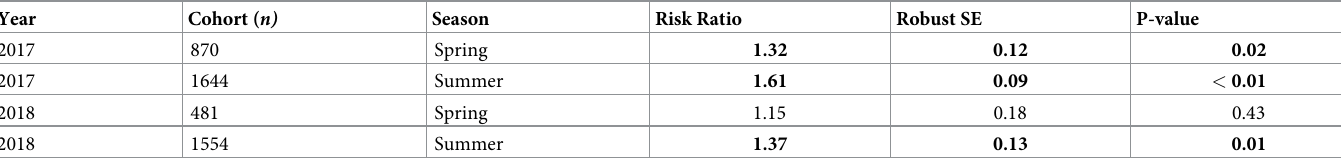
Risk ratios for roots born in the spring and summer seasons relative to the fall season in 2017 and 2018. Risk ratios > 1 show that risk of mortality was increased at that time of year compared to the fall season of birth, suggesting that lifespan was shorter. Risk ratios < 1 show that risk of mortality was decreased at that season of birth. Bolded text was statistically significant ( P < 0.05). Cohort sizes for fall seasons in 2017 (1237) and 2018